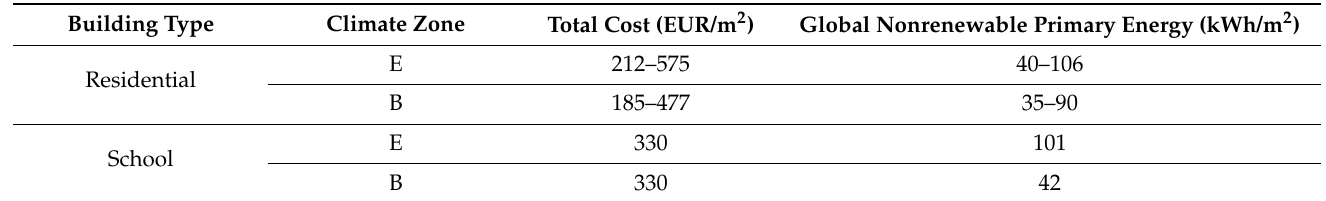
Table 4. Minimum total costs, optimal annual primary energy consumptions, nonrenewable primary energy (status quo), cost-optimal nonrenewable primary energy and related CO 2 -emission reductions for different types of residential buildings and schools [20].